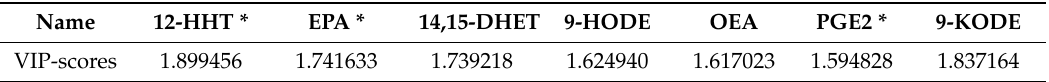
Figure 2. ( A ) The principal component analysis (PCA) performed to verify outliers. The 95% Hotelling T2 confidence interval is indicated as an ellipse. ( B ) The partial least square discriminant analysis (PLS-DA) model discriminating healthy control (HC) and Wilson disease patients (WD). The explained variance of each component is indicated in brackets on the corresponding axis. ( C ) PLS2-DA model represented in 3-D showing separation among the HC and WD patients. Table 2. Variable importance in projection (VIP) scores are shown for 7 metabolites. A cuto ff value of 1.5 is established for VIP